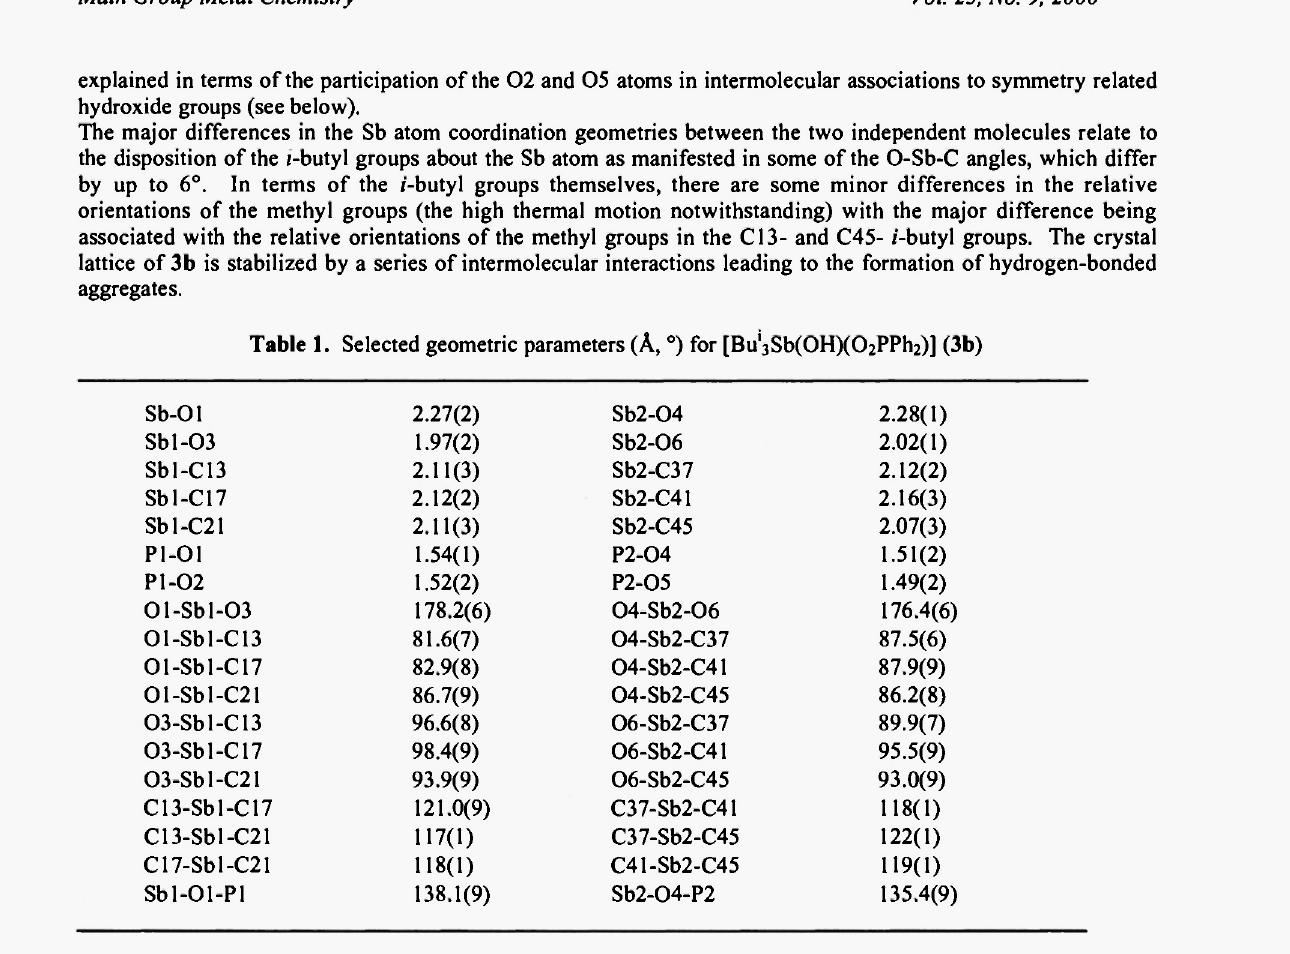
Table 1. Selected geometric parameters (A, °) for [Bu i 3 Sb(0H)(0 2 PPh 2 )]